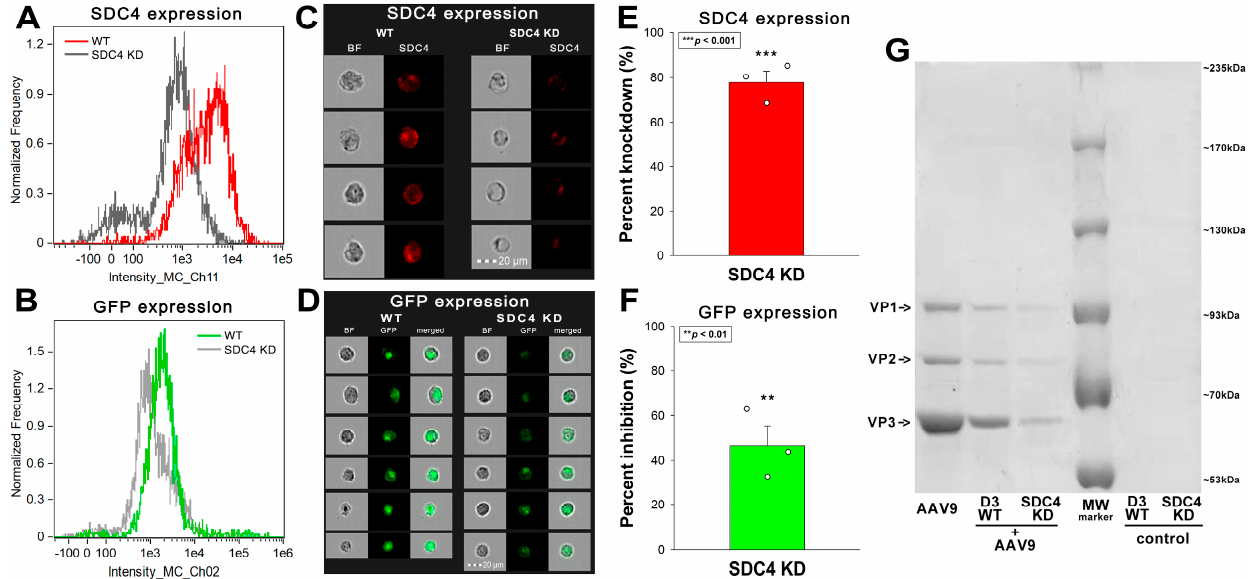
Figure 1. SDC4 contributes to AAV9’s entry into hCMEC/D3 cells. ( A-F ) Imaging flow cytometry assessment of SDC4 expression and AAV9-mediated gene (GFP) delivery in wild-type (WT) and SDC4 KD hCMEC/D3 cells. SDC4 KD was performed using SDC4-specific shRNA plasmids. WT and SDC4 KD hCMEC/D3 cells were treated 4 x 10 4 vg/cell AAV9-GFP for 72 h at 37 °C. SDC4 and GFP expression levels were measured with imaging flow cytometry, as shown by the representative histograms and cellular images of three independent experiments. Scale bar = 20 μ m. The effect of SDC4 KD on SDC4 and GFP expression expressed as percent inhibition. The bars represent the mean ± SEM of three independent experiments. Statistical significance vs. WT was assessed with analysis of variance (ANOVA). ** p < 0.01; *** p < 0.001. ( G ) SDS-PAGE showing VP1-3 immunoprecipitated with SDC4 from AAV9-treated (4 x 10 4 vg/cell AAv9 for 6 h at 37 °C) hCMEC/D3 cells’ extracts. Lane 1: 10 6 vg recombinant AAV9; lane 2-3: immunoprecipitates of AAV9-treated WT hCMEC/D3 and SDC4 KD cells; lane 4: MW marker; lane 5-6: immunoprecipitates of WT and SDC4 KD hCMEC/D3 cells untreated with AAV9 (i.e., controls). Standard protein size markers are indicated on the right. Confocal microscopic studies on hCMEC/D3 cells treated with AAV9 for 6 h revealed the overlap of AAV9 and SDC4 in AAV9-treated hCMEC/D3 cells, as shown by the high